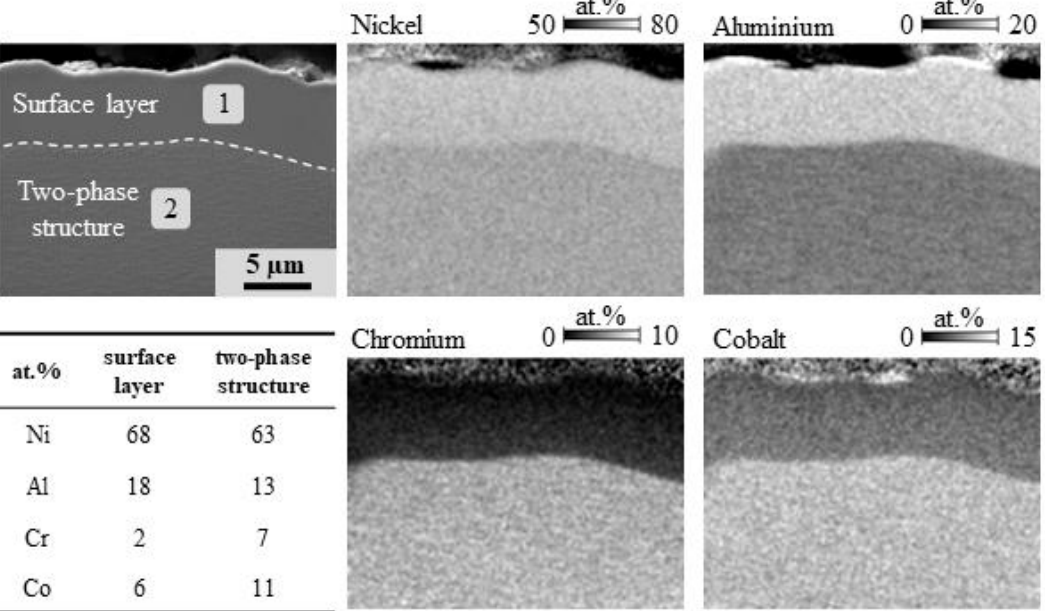
Figure 3. Chemical composition of the surface layer formed during heat treatment under vacuum.